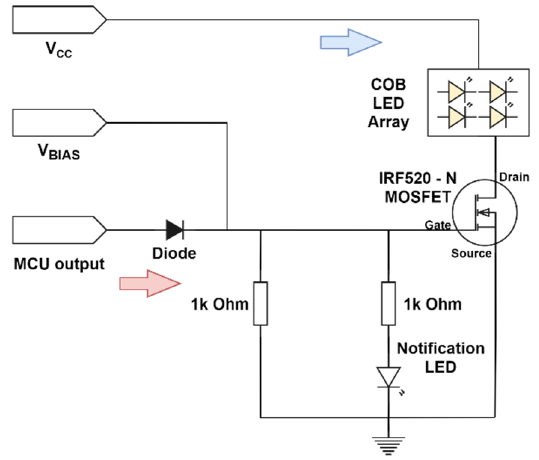
Figure 6. LED driver structure.